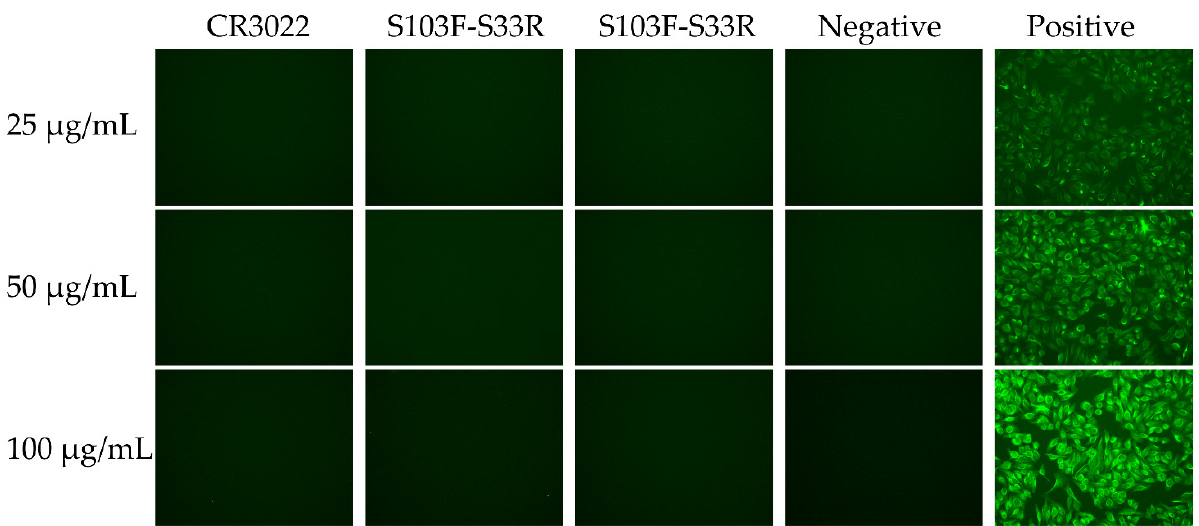
Figure 5. Autoimmune reactivity of wild-type and variants of CR3022 (CR3022, S103F–S33R and